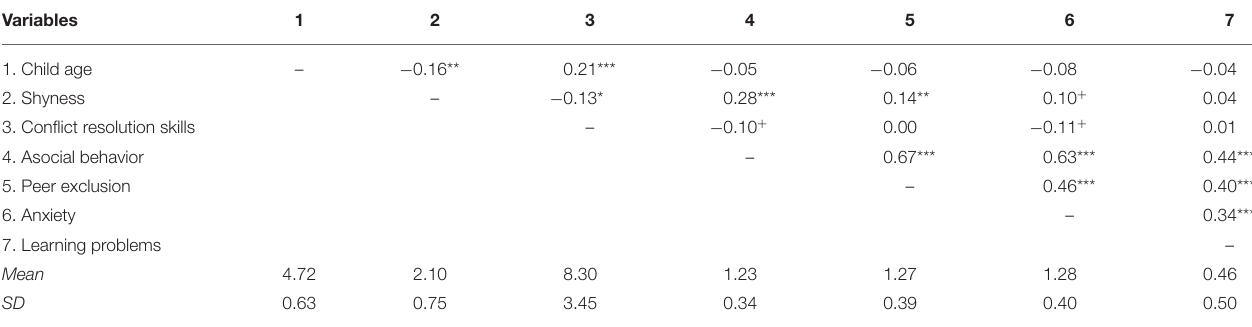
TABLE 1 | Descriptive data and correlations among variables.